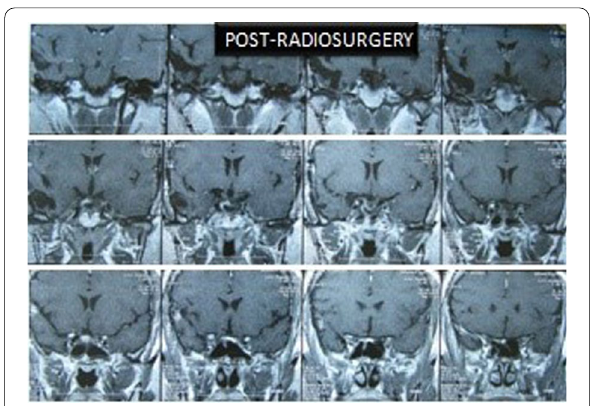
Fig. 4 Case N° 2: MRI brain (coronal cuts): post-GK